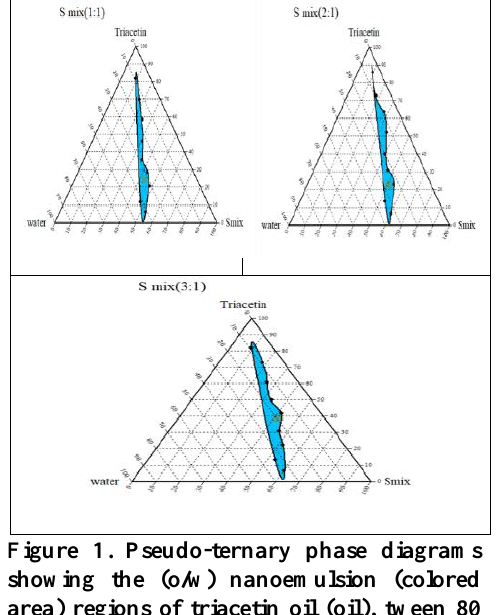
Figure 1. Pseudo-ternary phase diagrams showing the (o/w) nanoemulsion (colored area) regions of triacetin oil (oil), tween 80 and cremophore EL (1:1) ratio (surfactant mixture), tetraglycol (co-surfactant) at different Smix ratios (1:1, 2:1, and 3:1) at 25 °C.